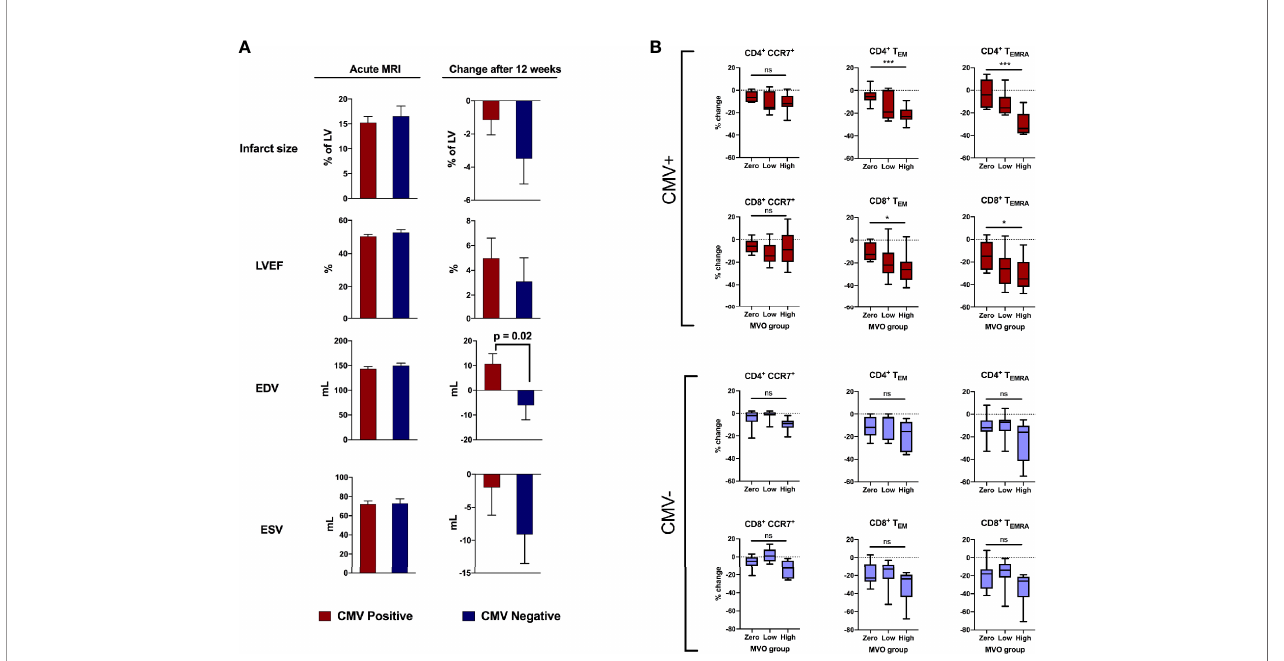
FIGURE 2 | CMV serostatus is associated with adverse remodeling 12 weeks after reperfusion. (A) In the acute phase (1-8 days post-reperfusion, n=101), CMV serostatus has no effect on infarct size, LV ejection fraction, end-diastolic volume or end-systolic volume. At 12-week follow-up (n=48), CMV seropositive patients displayed signi fi cantly more deterioration in end-diastolic volume (+10.7mL vs -6.1mL, p=0.02). P values determined using the unpaired t-test. (B) Relationship between amount of MVO (zero, low or high) and change in T cell subsets between 15-30 minutes post-reperfusion, separately for CMV seropositive and seronegative patients. Box plots display median (central line), 25 th and 75 th centiles (limits of box), and range (error bars). Statistics refer to differences between MVO groups as indicated (Kruskal-Wallis test with Dunn ’ s multiple comparisons test). Total n=47; CMV positive n=25 [8 zero MVO, 6 low, 11 high], CMV negative n=22 [9 zero MVO, 7 low, 6 high]). * p<0.05, ***p<0.001; ns, not signi fi